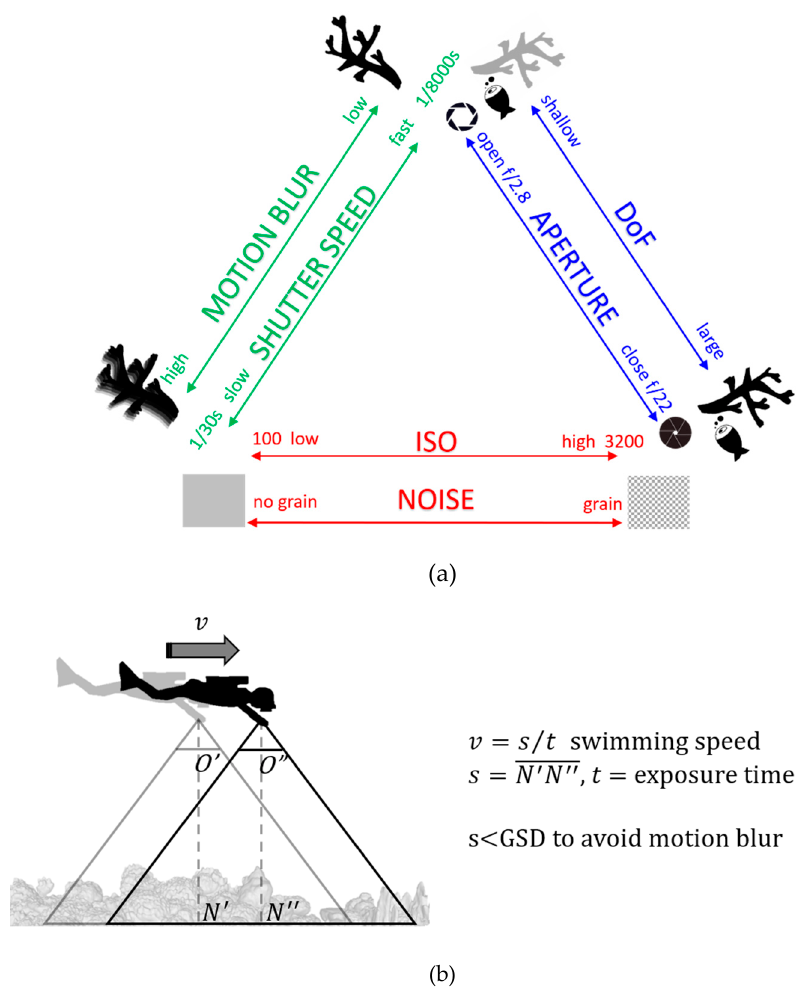
Figure 8. ( a ) The photographic exposure triangle and ( b ) relation between motion speed, v , and shutter or exposure time, t : given the swimming speed, v , the shutter speed, t , needs to be set so that the displacement, s , during the exposure time, t , is less than the GSD.